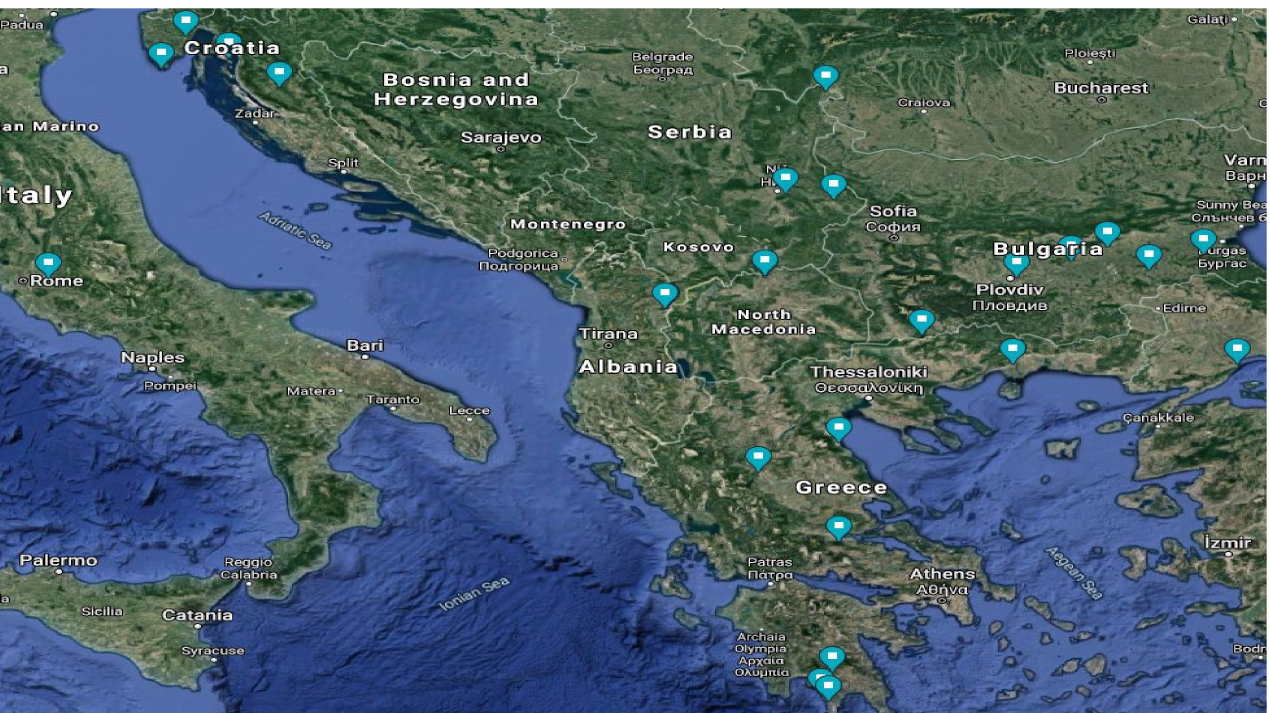
Figure 1. Map of collected accessions of Dasypyrum villosum